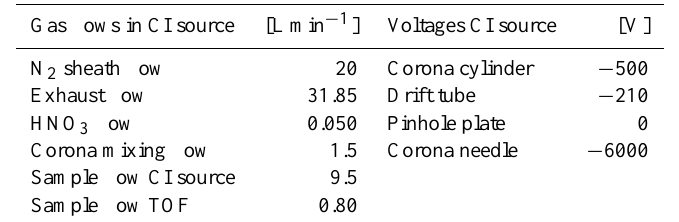
Table A1. Voltage and flow settings of the CI source. The basic design of the CI source is given in Kürten et al. (2011); however, the HNO 3 and corona mixing flow were not fed into the source together with the N 2 sheath flow, but directly over the corona needle. The electrostatic lens in front of the pinhole and the N 2 buffer flow were omitted in our CI source. The corona needle voltage given below is reduced by a 500M (cid:127) resistor before being applied to the needle itself.